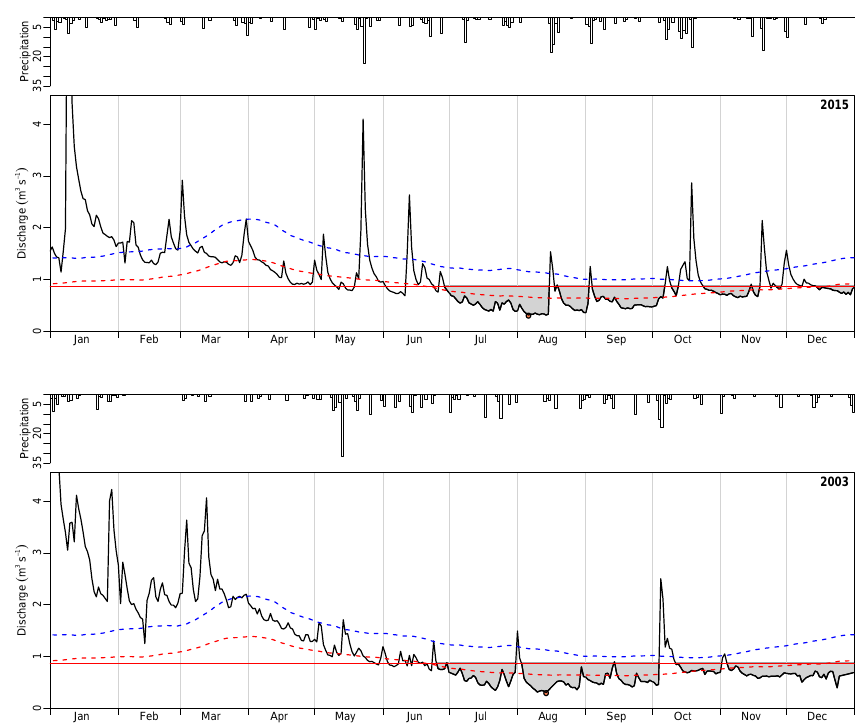
Figure 5. Hydrograph of gauge Imbach at the river Krems, northern Austria (black line, large panels) together with daily precipitation sums in millimeters (mm; smaller panels above the hydrograph). Preconditions were much drier in 2015 than in 2003. Same signatures as Fig.